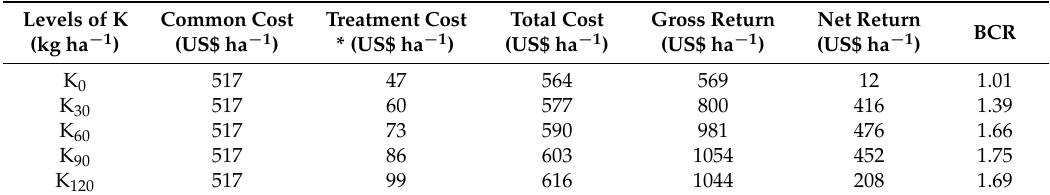
Table 7. Economic analysis of hybrid rice (var. Arize 6444) cultivation as influenced by potassium fertilization (means for 2016 and